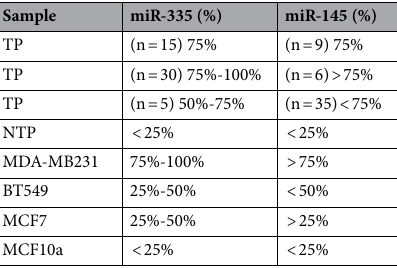
Table 1. Methylation level of tumor suppressor miR-335 and -145 promoter in cell lines, breast cancer samples and normal tissues. TP, tumor patient; NTP, non tumor